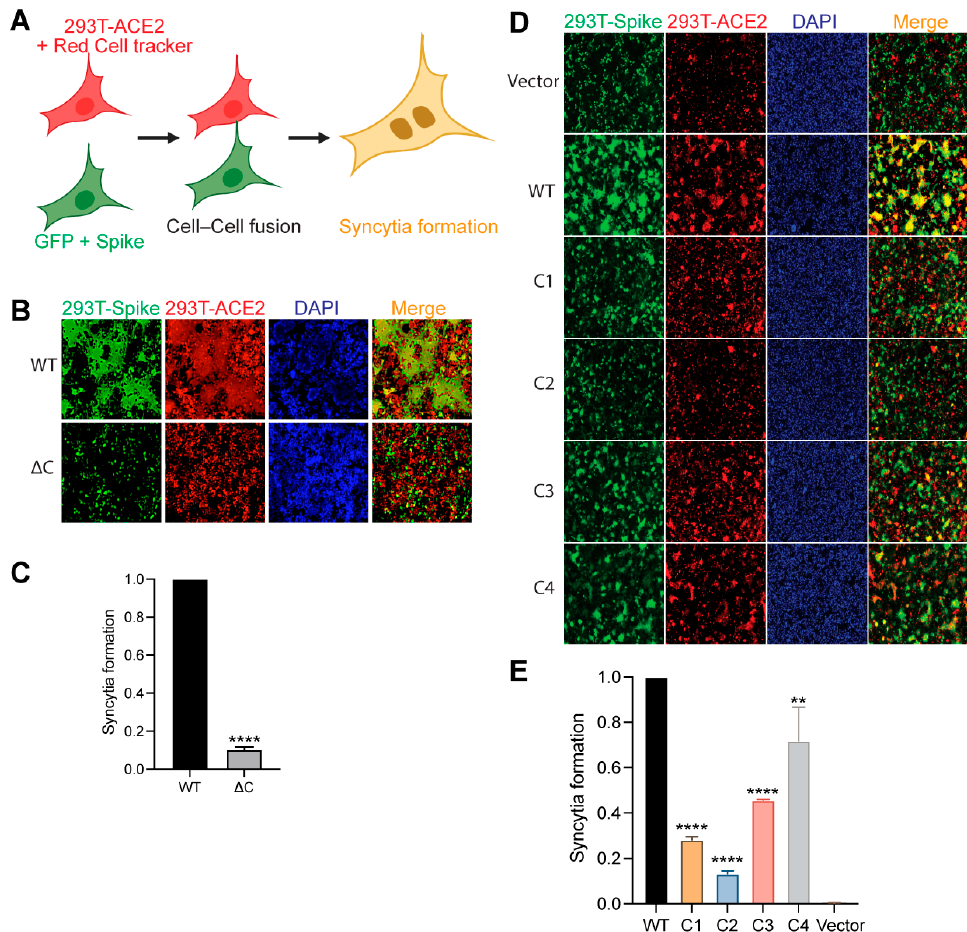
Figure 3. SARS-CoV-2 S protein palmitoylation is required for cell–cell fusion and syncytia formation. ( A ) Schematic representation of dual fluorescent syncytia formation assay. HEK293T-EGFP cells were transfected with WT S or its cysteine mutant plasmids. After 24 h, cells were detached and mixed with HEK293T-ACE2 cells labeled with cell tracker red CMPTX dye. After another 24 h, syncytia formation was evaluated by visualizing the yellow fluorescence formed by the fusion of the green and red cells. ( B ) Dual fluorescent syncytia formation assay with WT S and S ∆ C and ( C ) quantification of cell–cell fusion ability by measuring the pixel density of the observed syncytia. ( D , E ) Same as in B and C, but with cysteine cluster mutants of the S protein. Data shown are averages of the results of at least three independent experiments ± SD. (** p < 0.01; **** p < 0.0001 ( t -test)).